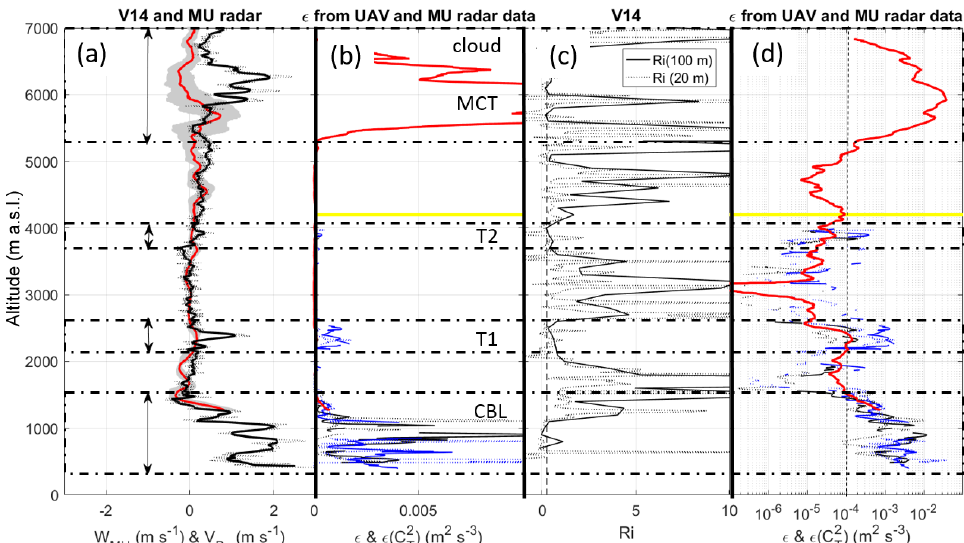
Figure 5. (a) Vertical profile of V Bc (ms − 1 ) (solid black: smoothed; dotted black: raw) for V14 and W MU (ms − 1 ) (red). The gray area shows the standard deviation of W MU over the averaging time (2min). The vertical arrows indicate the altitude ranges affected by turbulence. (b) Vertical profiles of TKE dissipation rates ε obtained from MU radar measurements (red) and UAV measurements during ascent and descent (black and blue) and using the direct and indirect methods (solid and dashed lines). The maximum altitude reached by the UAV is shown by the horizontal gray line. (c) Vertical profiles of Richardson numbers at a resolution of 20m (dashed) and 100m (solid). The vertical dashed line indicates Ri = 0 . 25. (d) Same as (b) in log scale. The vertical dashed line indicates the value of ε = 10 − 4 m 2 s − 3